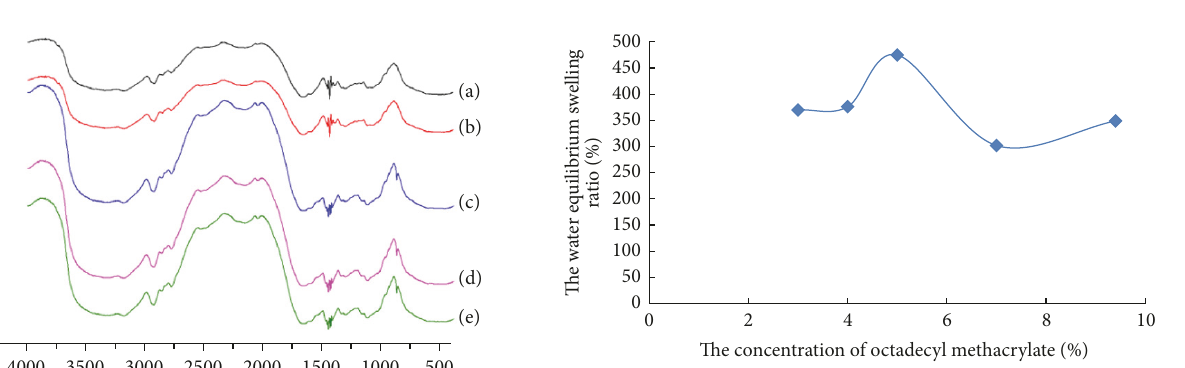
Figure 3: The solution absorption ratio of octadecyl methacrylate-